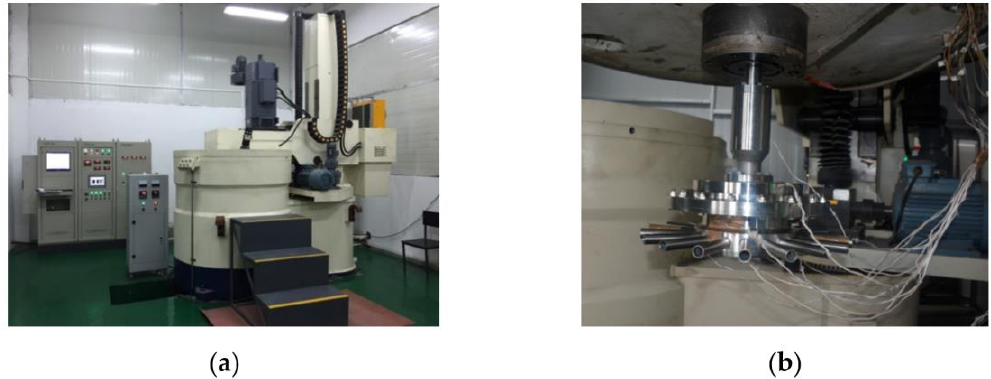
Figure 10. Test equipment: ( a ) The rotor high-speed rotating tester; ( b ) Installation schematic.